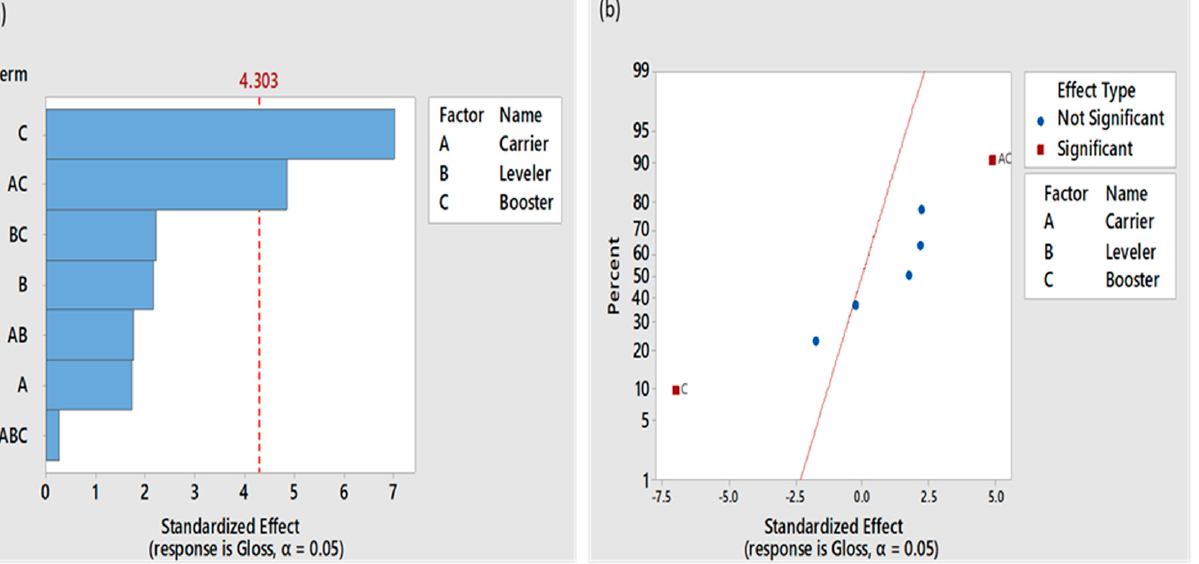
Figure 3. ( a ) Pareto chart and ( b ) Normal probability plot of the standardized effects of additives on gloss as determined by ANOVA with significant set at α < 0.05.